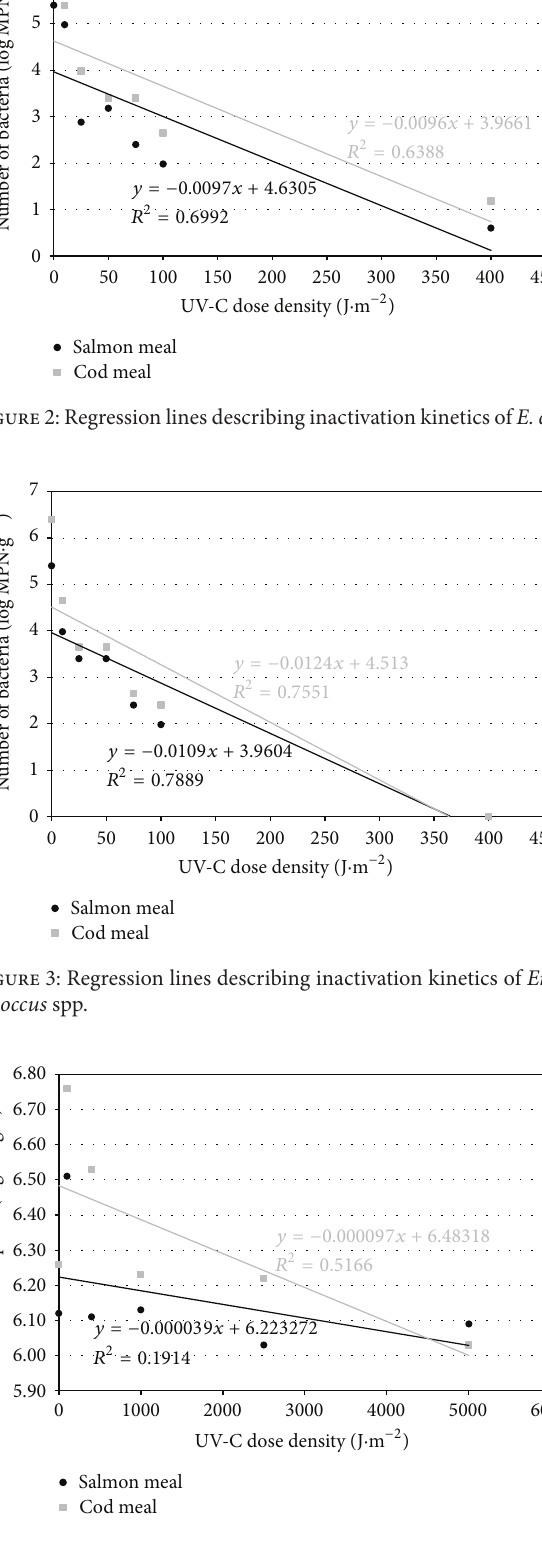
Figure 4: Regression lines describing inactivation kinetics of Clo– stridium sporogenes